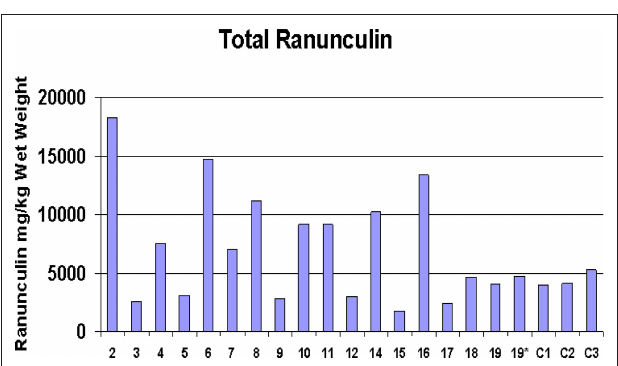
FIGURE 5 | Buttercup ranunculin content. Levels of ranunculin from EGS site Ranunculus samples compared with control samples (C1–C3). Note EGS site 19* sample freeze-dried after 2 months of storage in the freezer at − 20 ° C; EGS site 19 sample freeze-dried immediately after